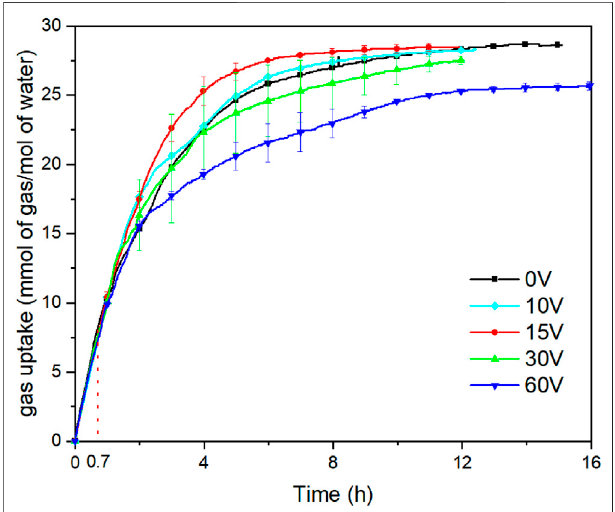
FIGURE 7 | Gas uptake in the application of different voltages at 3.5 MPa and 274.15